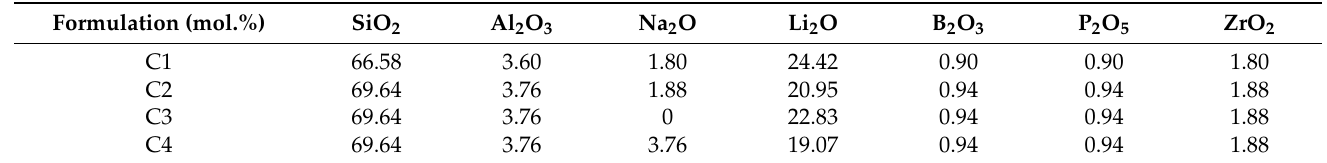
Table 1. Composition design of Li 2 O–Al 2 O 3 –SiO 2 system glass-ceramics (mol%). Formulation